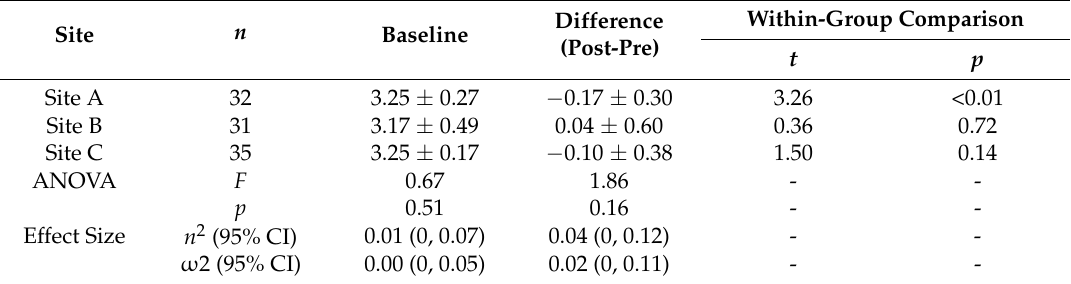
Table 2. Pre- and post-visit comparison of levels of cortisol across the three sites (n = 98). Site